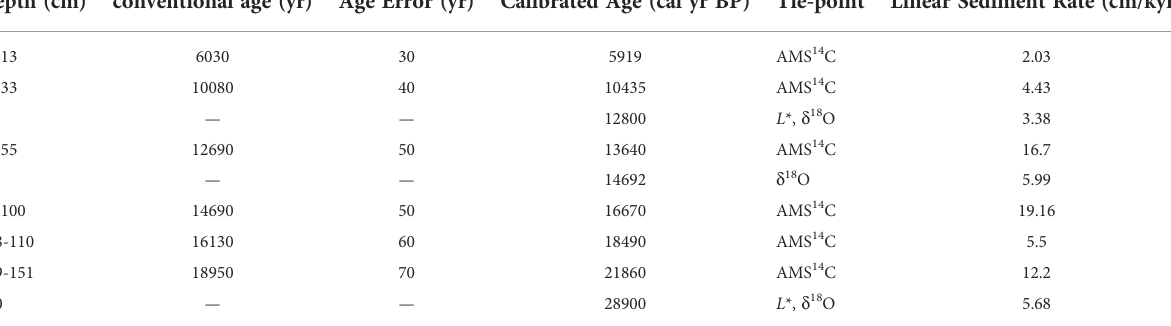
TABLE 1 Age model for the upper part (0-190 cm) of core LV63-4-2 according to AMS 14 C data of Zhong et al. (2020). Depth